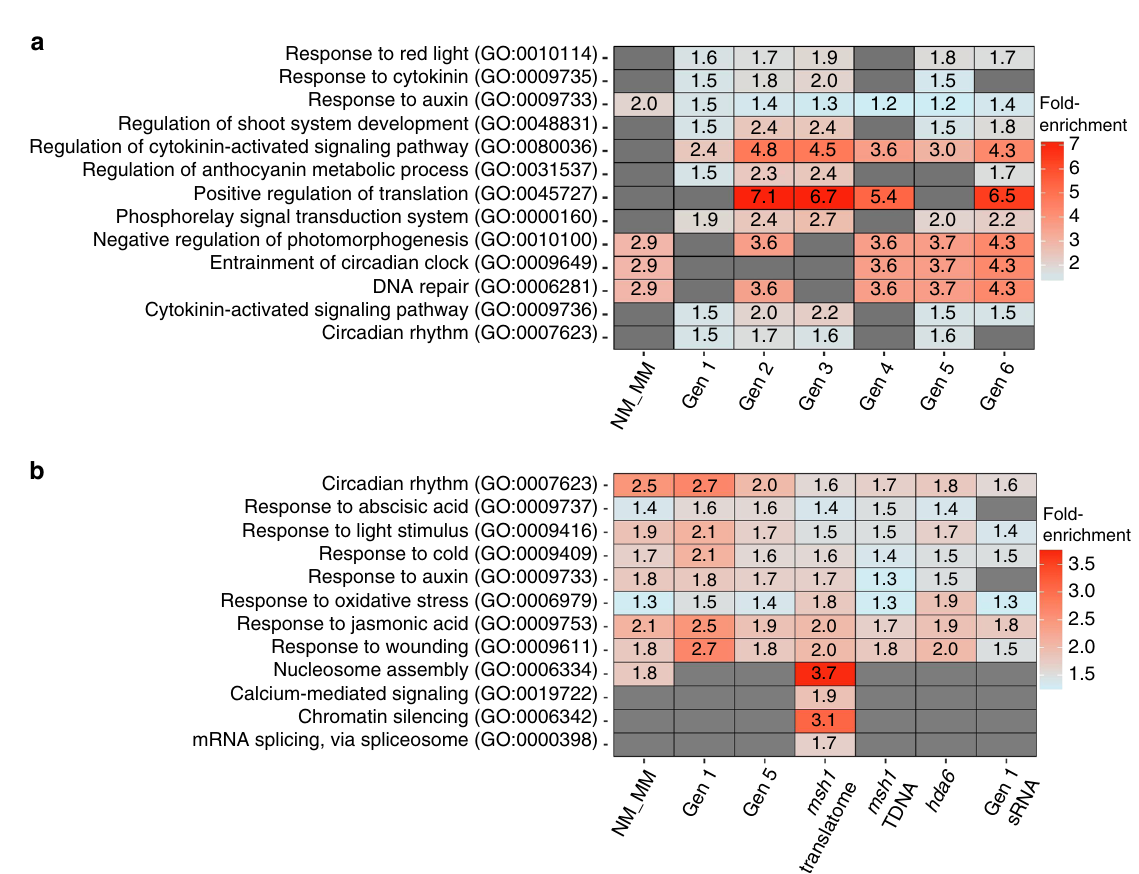
Fig. 5 Statistically signi fi cant overenrichment of gene networks. a Networks identi fi ed by NEAT (Network Enrichment Analysis Test) for the DMGs identi fi ed in msh1 memory line by MethylIT. The full list of DMGs for each generation of the memory line is listed in Supplementary Data 2. b Functional enrichment analysis of DEGs in msh1 memory line, msh1 mutant translatome and msh1 T-DNA mutant. GO biological process enrichment categories above the cutoff, FDR < 0.01, are shown. DAVID GO was used to conduct the analysis 76 . The msh1 T-DNA mutant expression data were generated and reported in Shao et al. 16 . The msh1 mutant translatome refers to the MSH1 cell type-speci fi c TRAPseq dataset that was reported in Beltrán et al. 20 . The hda6 transcriptome data were taken from Yu et al. 27 and reanalyzed using our pipeline. For Gen1 sRNA, genes within ±1 kb of differentially expressed sRNA clusters were used for the GO analysis. Source data for generational DMGs are provided as a Source Data fi